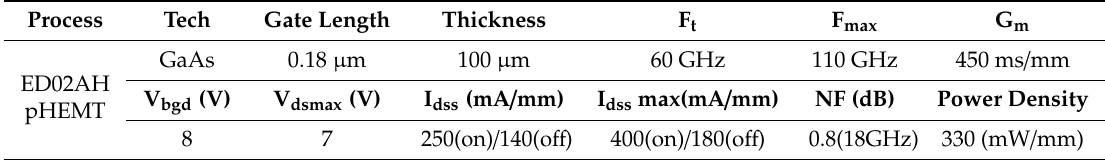
Table 1. The physical characteristics of transistor ED02AH.